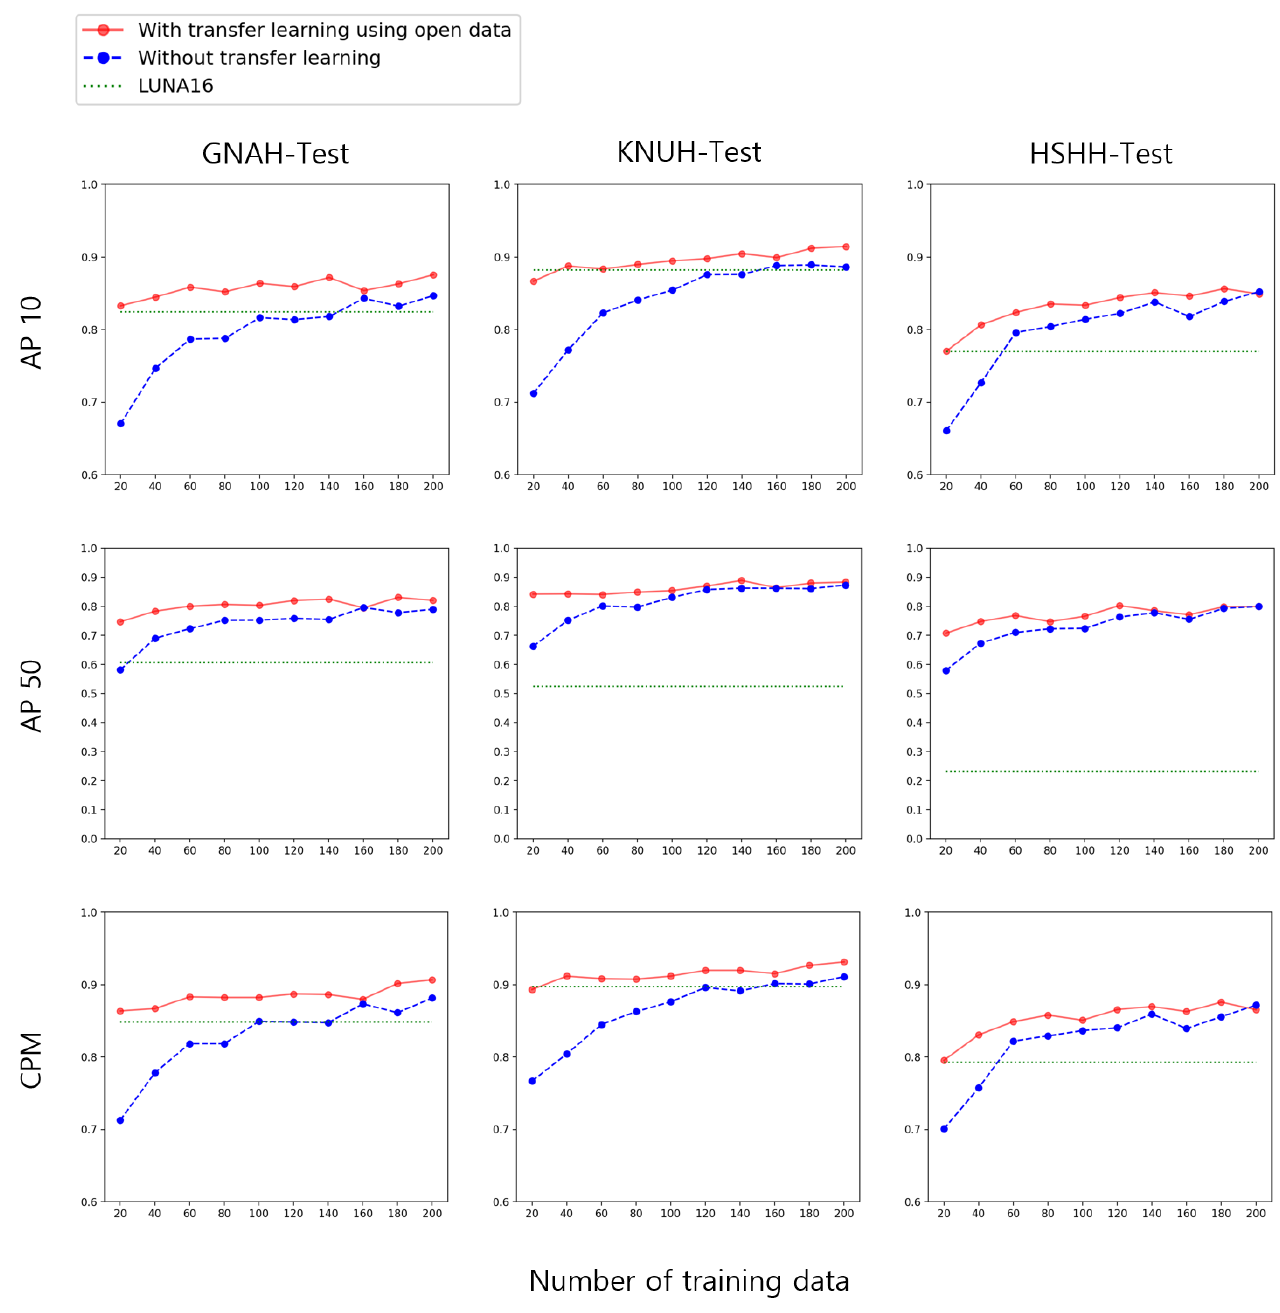
Figure A3. Experiment 3 — EfficientDet.